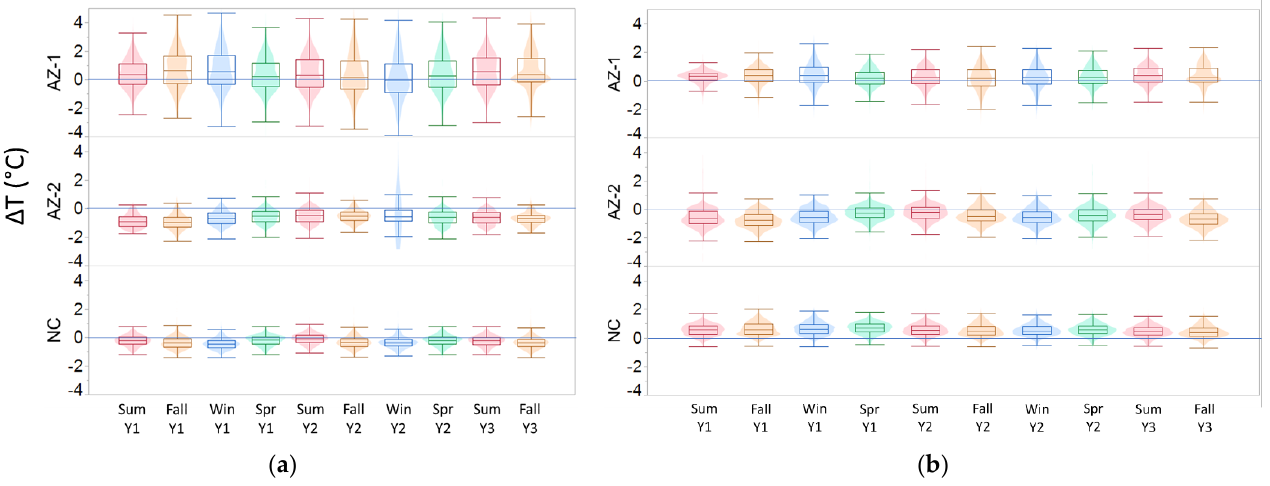
Figure 2. Violin plots representing ΔT backsheet seasonal trends over 10 seasons/two and a half year initiating from summer (Sum Y1) to fall (Fall Y3) in one-cell modules installed at three different sites (AZ-1, AZ-2 and NC). ( a ) TPT-TCB_A and ( b ) TPT-TCB_B.